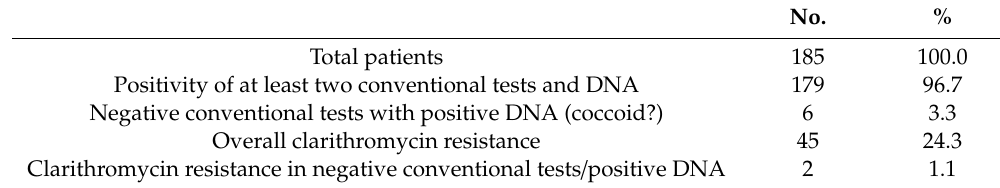
Table 1. Data from a series of 185 H. pylori positive dyspeptic subjects, in whom at least one therapeutic antibiotic regimen had failed. The combination of negative conventional tests / positive DNA may reflect the presence of coccoid forms. No. % Total patients 100.0 Positivity of at least two conventional tests and DNA 179 Negative conventional tests with positive DNA (coccoid?) Overall clarithromycin resistance Clarithromycin resistance in negative conventional tests / positive